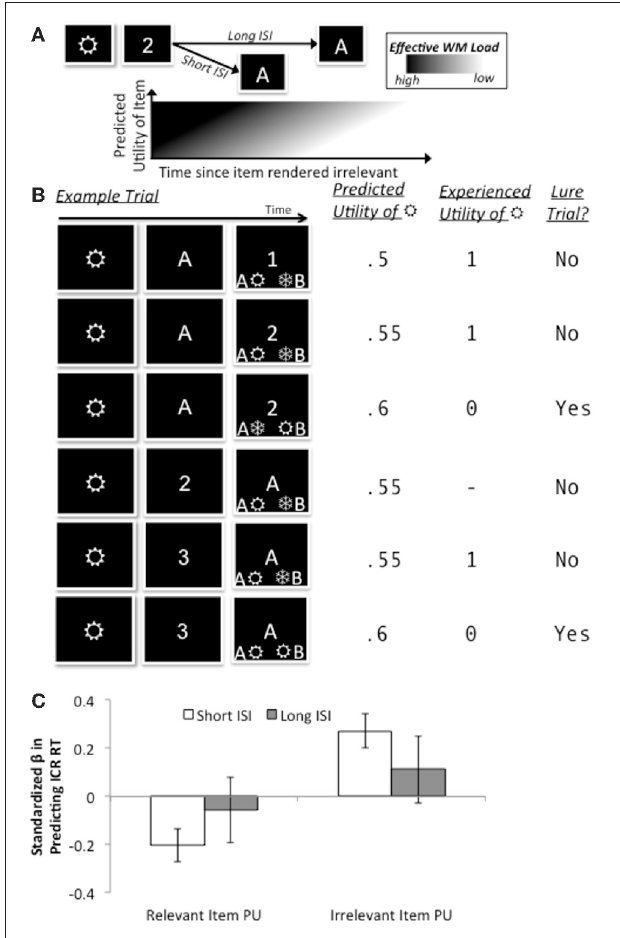
FIGURE 3 | Conceptual schematic of computational model (A), trial-by-trial RL-like updating of utilities (B), and significant fits to RT in the ICR condition as a function of ISI (C). (A) The key conceptual assumption in our model is that the benefit of a longer ISI to RT and accuracy in the ICR condition reflects a sluggish reduction in effective WM load following the presentation of context, but that this sluggishness is exacerbated for irrelevant items that had a higher predicted utility. (B) Several examples illustrate how predicted and experienced utilities for an example item (“ ”) change across trials. In the first illustrated trial, is specified as relevant by the context and is associated with the correct response, therefore acquiring an experienced utility of 1; the predicted utility on the following trial is updated by the resulting utility prediction error, scaled by the learning rate (here, 0.09). On this second trial, “ ” is specified as irrelevant (due to the context) but is still associated with the correct response, and thus again acquires an experienced utility of 1. This experience changes its predicted utility for the third trial, where it is now associated with the incorrect response, and acquires zero experienced utility. In the fourth trial, is not eligible for experienced utility because it should not be held within WM (the context had rendered it irrelevant), whereas in the fifth and sixth trials, R is associated/not associated (respectively) with the correct response and acquires utilities of 1/0, respectively. (C) At the short ISI of the ICR condition, the predicted utility of irrelevant items was positively correlated with RT (“irrelevant utility cost”), whereas the predicted utility of the relevant items was negatively correlated (“relevant utility benefit”). These effects were diminished at the long